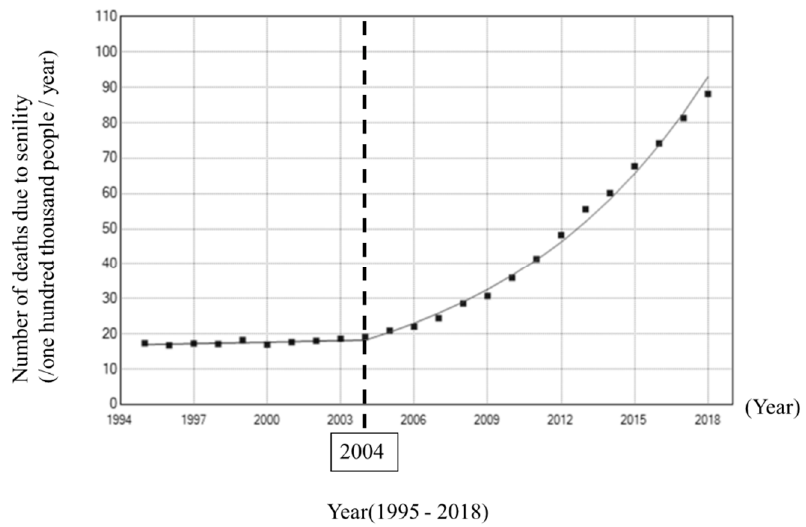
Figure 2. Jointpoint analysis of the number of deaths due to senility.